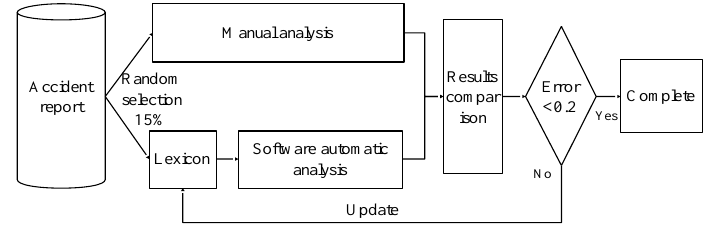
Figure 2. Lexicon development process.